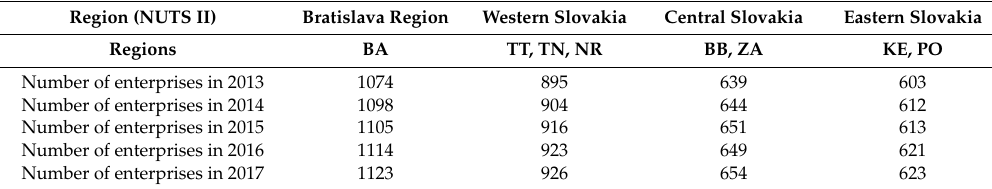
Table 1. Regional structure of enterprises with over 50 employees. NUTS—Nomenclature of Territorial Units for Statistics.